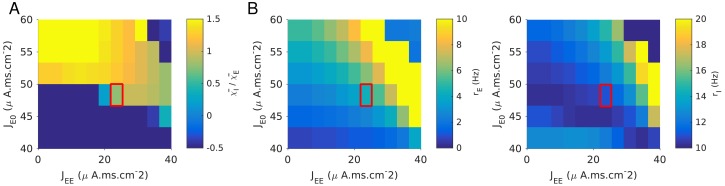
Model 1.The response of the PC and PV populations upon stimulation of the latter are proportional only if parameters are fine-tuned. (A) χ-I/χ-E where χ-A=(rAlightonrA-1)/Γopto estimated for Γopto=0.5mW.mm-2. (B) Red square indicates the region of the parameter space for which the ratio of the PC and PV slopes 1 ± 0.3 and activities are reasonable (rE < 5 Hz, 5Hz < rI < 10 Hz). Parameters as in Figure 5. K = 500.